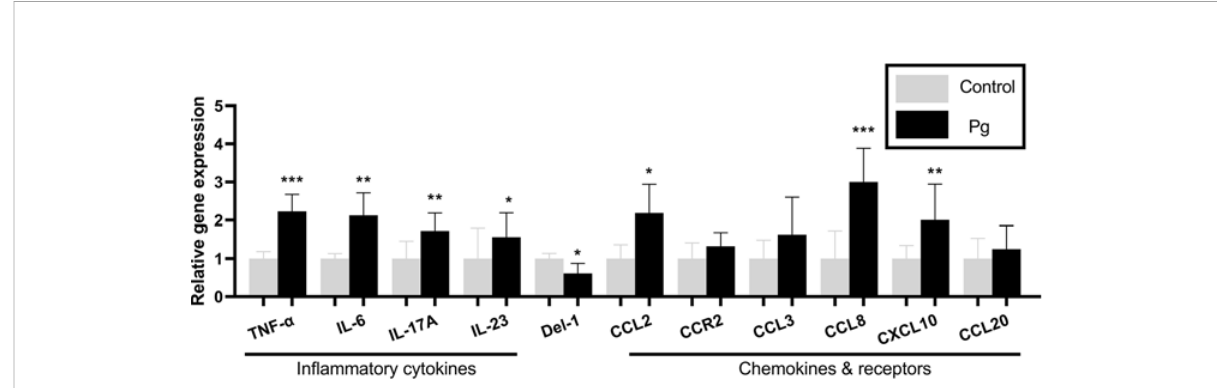
FIGURE 3 Effects of the oral administration of Porphyromonas gingivalis on the gene expressions of in fl ammatory cytokines and chemokines in the gingiva of mice in the P. gingivalis -administered group and the control group. The relative mRNA expressions of the genes of interest were normalized to the relative quantity of glyceraldehyde 3-phosphate dehydrogenase ( GAPDH ) mRNA. * p < 0.05, ** p < 0.01, *** p < 0.001. N = 6. Data are expressed as the mean ± SEM.